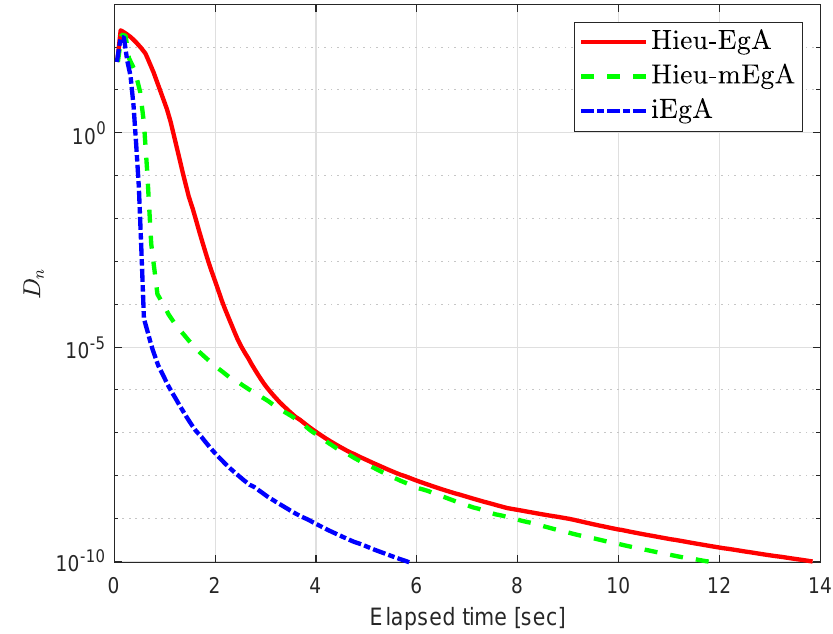
Figure 9. Example 3: Numerical comparison for Algorithm 1 while ζ n = 1